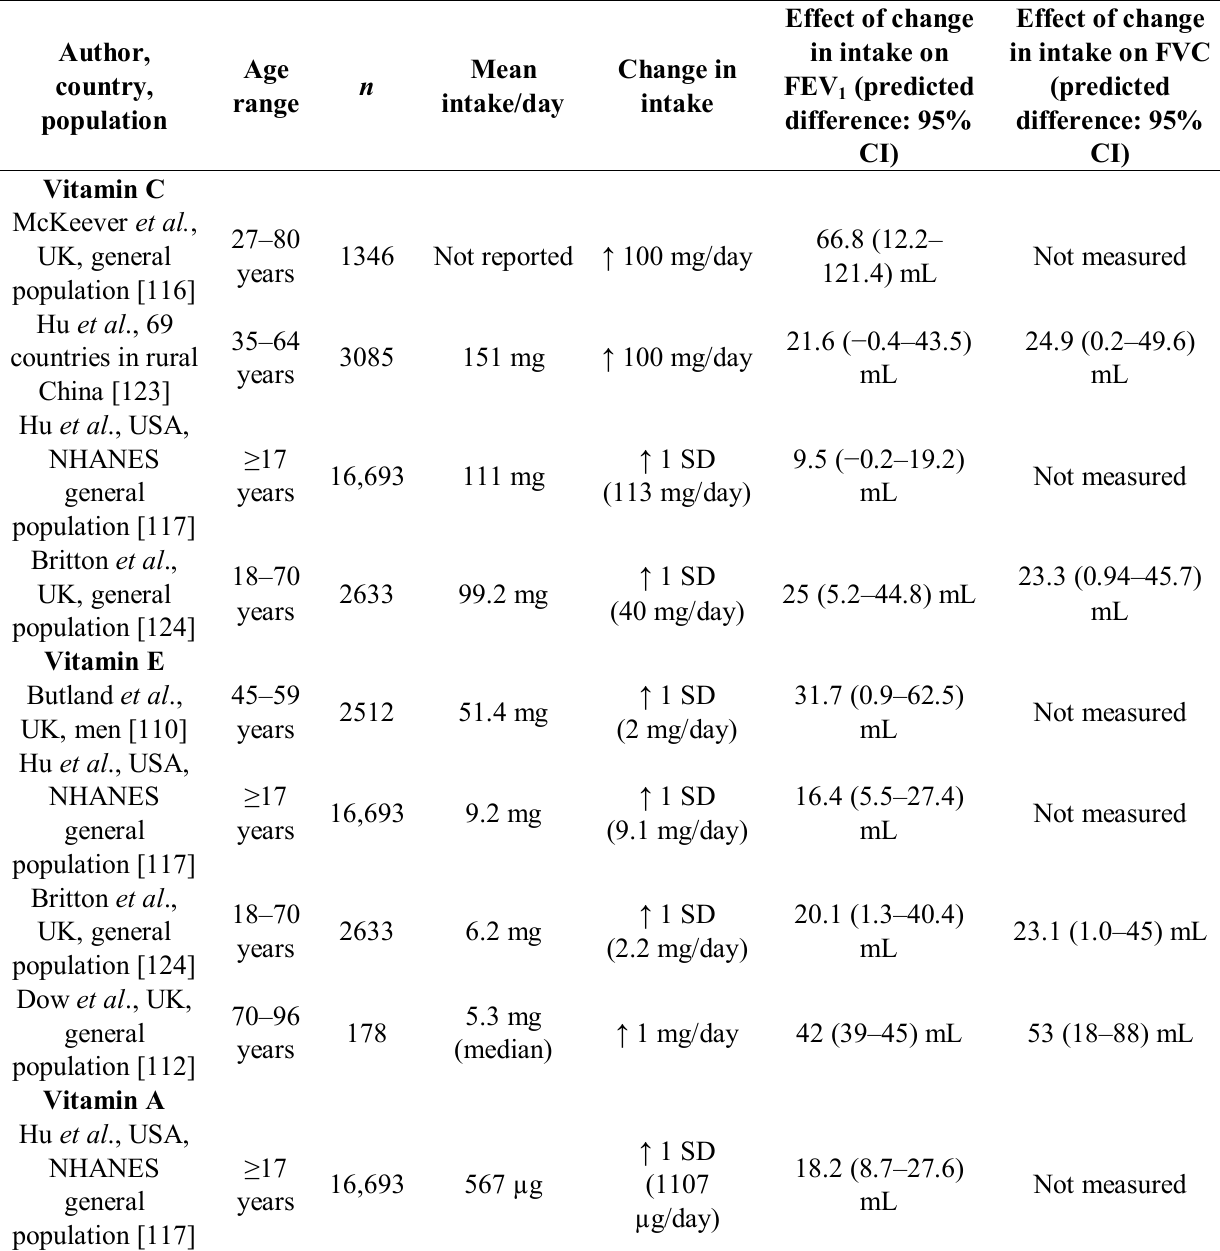
Table 2. Cross-sectional associations between dietary intakes of antioxidant vitamins C, E, and A, and lung function in adults with